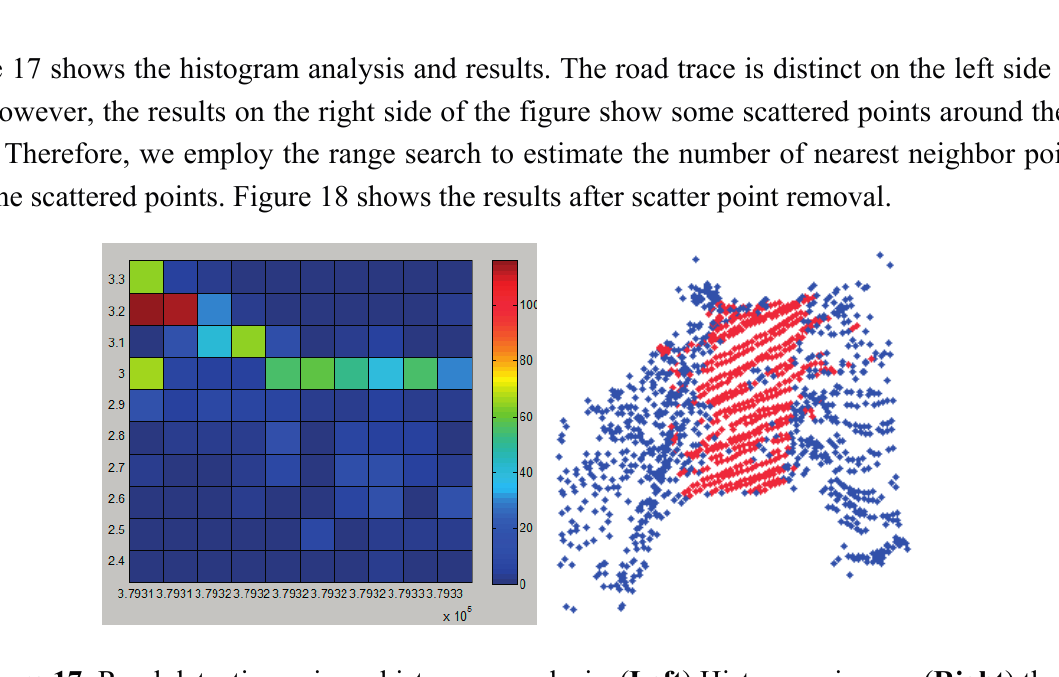
Figure 17. Road detection using a histogram analysis. ( Left ) Histogram image; ( Right ) the results of the road detection.